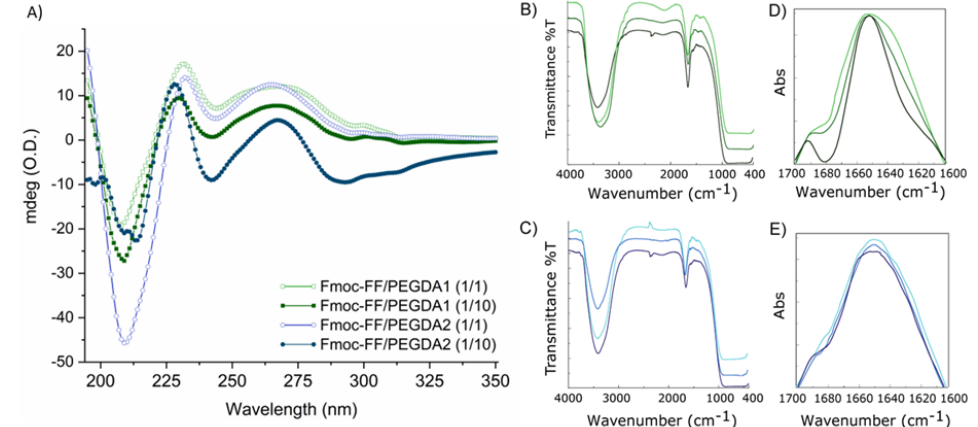
Figure 3. ( A ) CD spectra (in the 190 and 350 nm range) of Fmoc-FF/PEGDA1 (1/1 and 1/10) and Fmoc-FF/PEGDA2 (1/1 and 1/10). FTIR characterization. ( B ) FTIR spectra of Fmoc-FF/PEGDA1 matrices (1/1, light green; 1/5, green grass; and 1/10, dark green). ( C ) FTIR spectra of Fmoc-FF/PEGDA2 matrices (1/1, light blue; 1/5, blue; and 1/10, dark blue). Amide I deconvolution profiles of PEGDA1 ( D ) and PEGDA2 matrices ( E ).